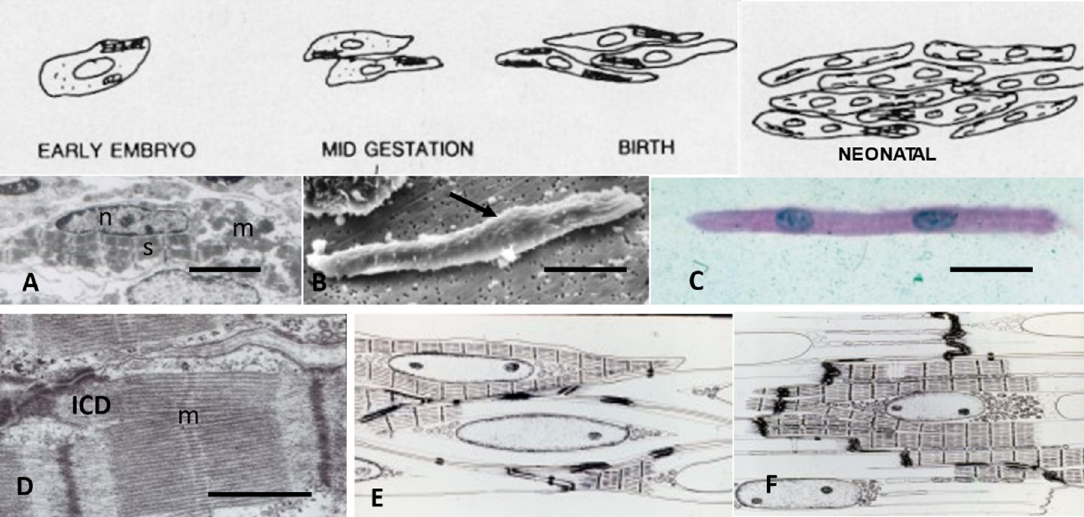
Figure 3. ( A ) Fetal cardiomyocyte with immature sarcomeres (s), mitochondria (m), and nucleus (n). ( B ) Isolated newborn cardiomyocyte with a single nucleus (arrow). ( C ) Neonatal isolated cardiomy- ocyte with two nuclei. Bar in A = 5 µm, Bar in B and C = 10 µm. ( D ) Electron micrograph of P10 rat. Myofilaments attached to intercalated disc adherens junction (ICD). Sarcomere complete with M-band (m). Bar = 1 µm. ( E ) Schematic drawing of P1 spindle-shaped neonatal cardiomyocytes. ( F ) Schematic drawing of P10 neonatal cardiomyocytes. Lateral adherens junctions (dark) move to the cell end to form the ICD.